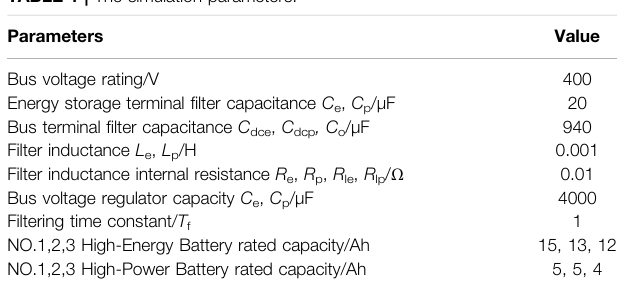
TABLE 1 | The simulation parameters.